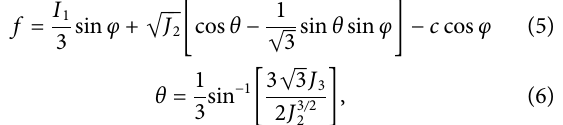
Figure 2 . The geotechnical parameters of the foundation soil were referenced from Yu et al. (2021). The excavated soil was modeled using an elastic-plastic constitutive model with Mohr – Coulomb yield criterion and the non-associated fl ow rule. The failure surface of the Mohr – Coulomb yield criterion can be described in Eqs 5, 6 (Lee and Bobet, 2014; Li et al., 2005). All of the analyses were performed using meshes made up of 4th order 15-node triangles within each rectangle. The base length and width of slope were both fi xed as 150 m in the simulation, being half of the designed values of the dumpsite on account of the model symmetry. The deformation of bottom boundary was fi xed, while the deformation of the top boundary was allowed to move freely in both horizontal and vertical directions. In addition, the deformation of the two side boundaries was fi xed in the horizontal direction but was allowed to move freely in the vertical direction (Gao et al., 2020). The fl ow of the left side boundary was closed; however, the fl ows of the bottom boundary and the top and right side boundaries were open.